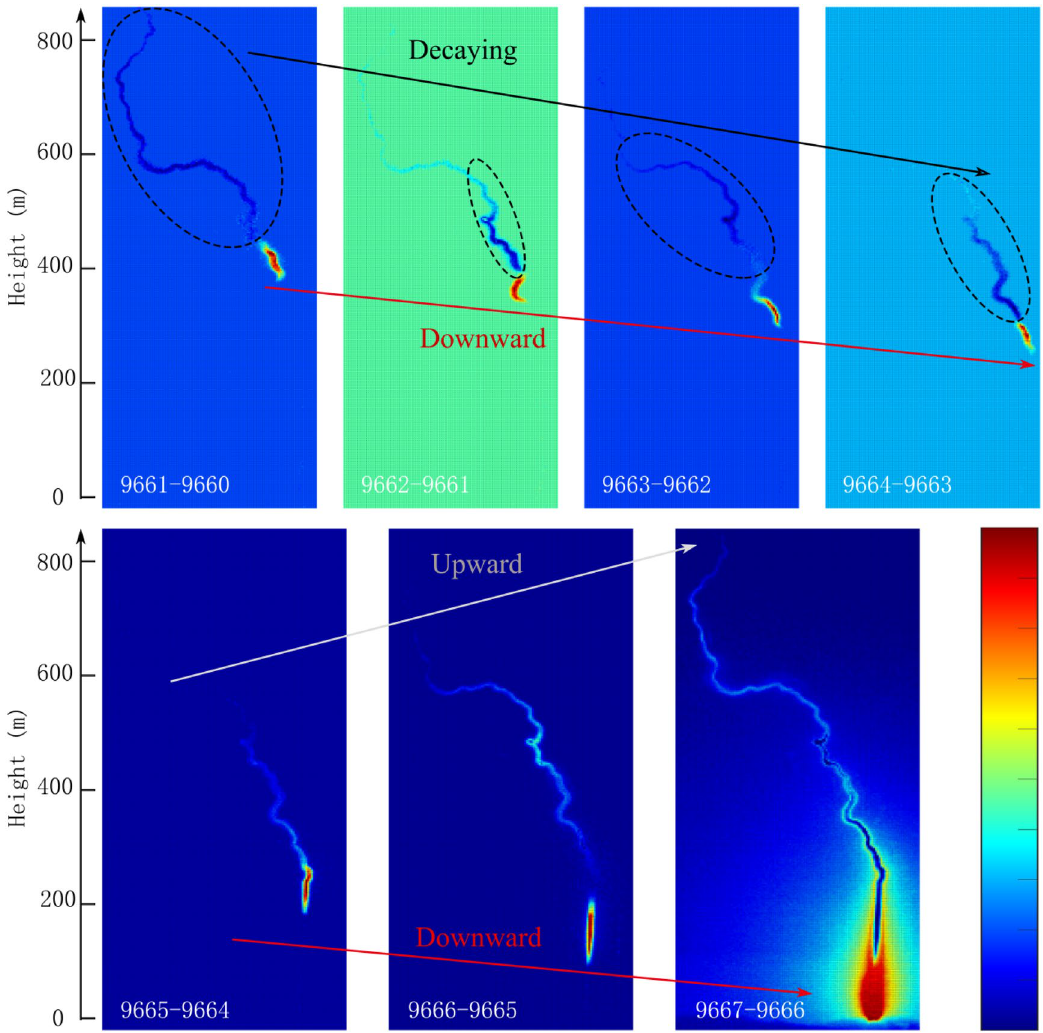
Figure 4. Differential luminosity from frame-to-frame of the frames in Fig. 3. The color range of each image is from the minimum value to the maximum value of the differential luminosity. The background color usually represents a differential light intensity of 0 which means that the luminosity of the corresponding position of the two frames remains unchanged. According to the color bar, redder means brighter and bluer means darker relative to the background